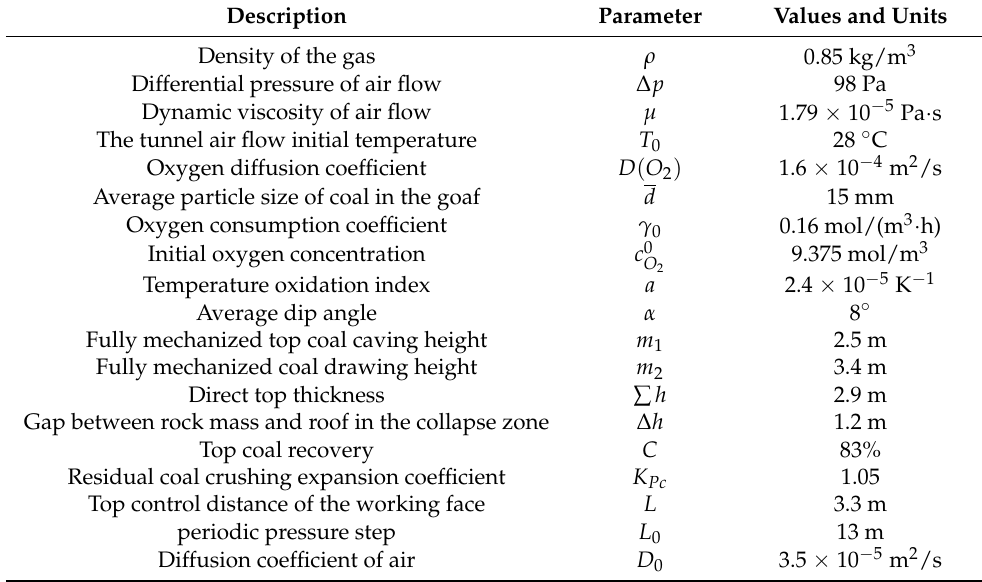
Table 1. Model Table 1. Model parameters.